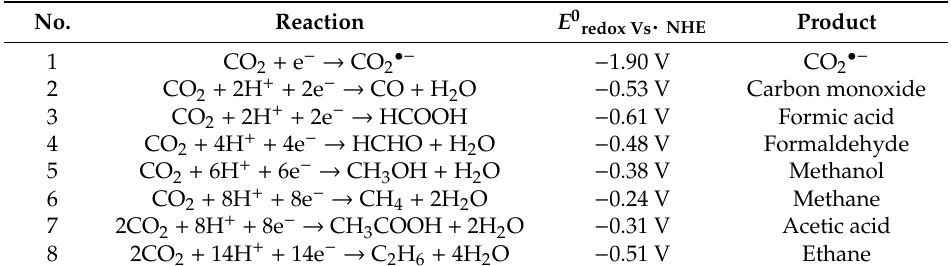
Table 1. The catalytic pathway of CO 2 reduction towards various main products with their redox potentials (at pH =